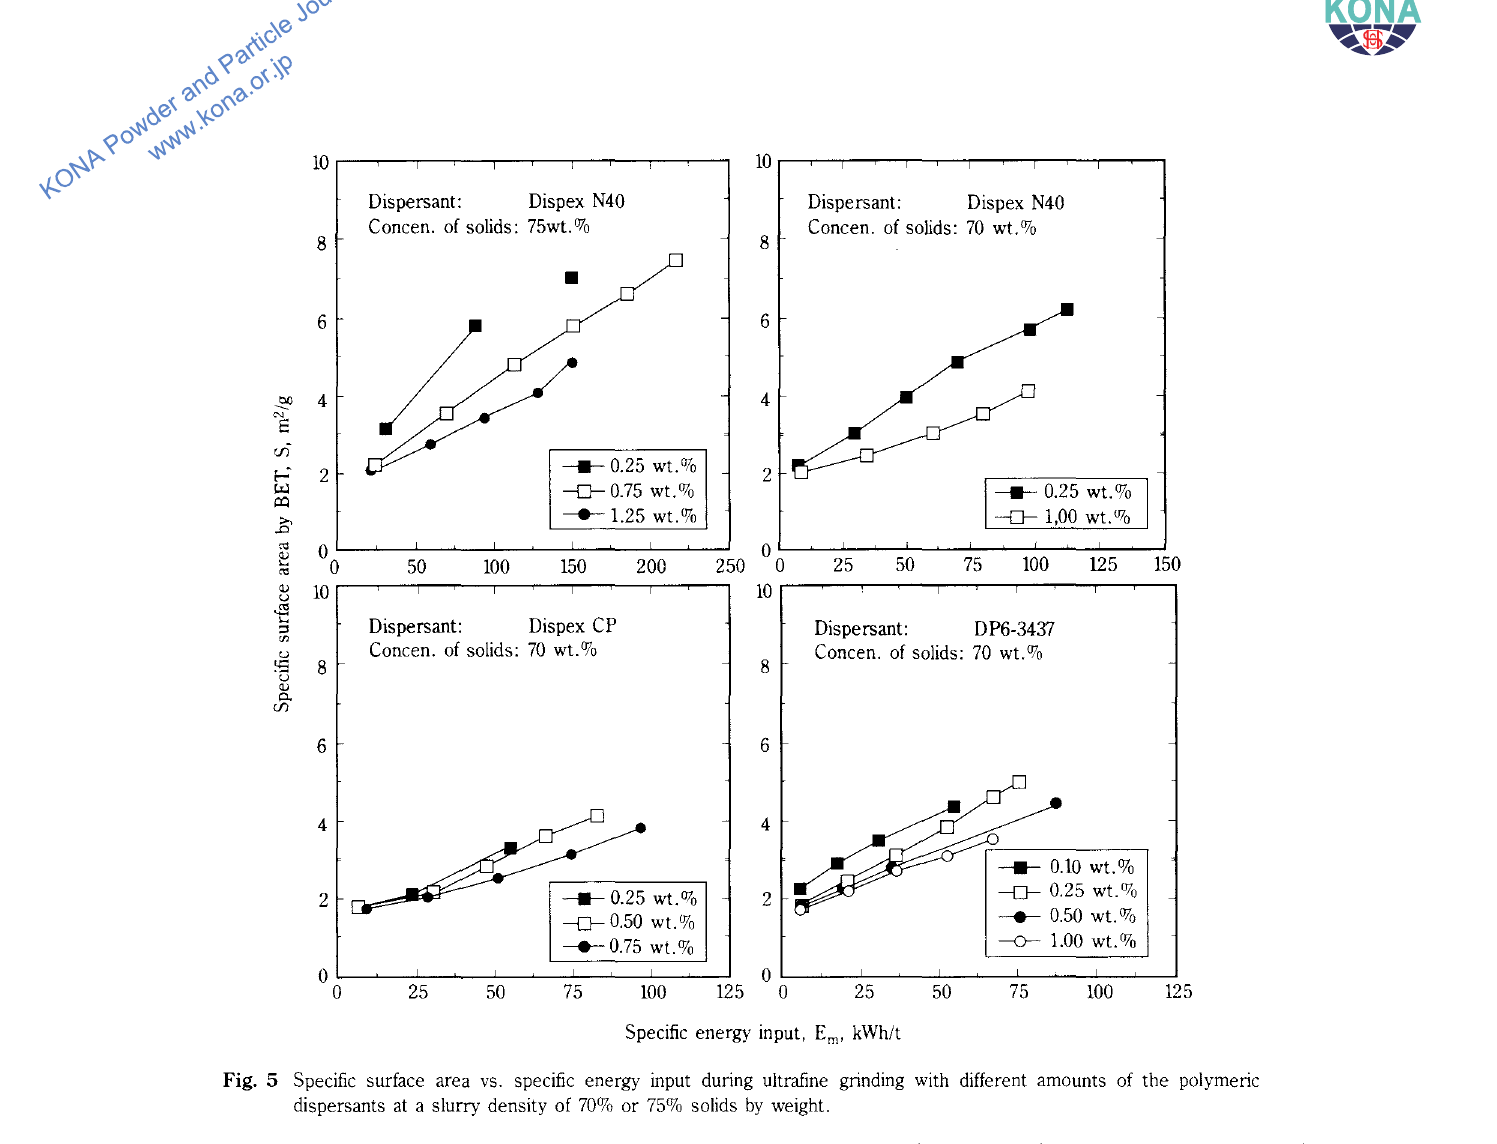
Fig. 5 Specific surface area vs. specific energy input during ultrafine grinding with different amounts of the polymeric dispersants at a slurry density of 70% or 75% solids by weight.